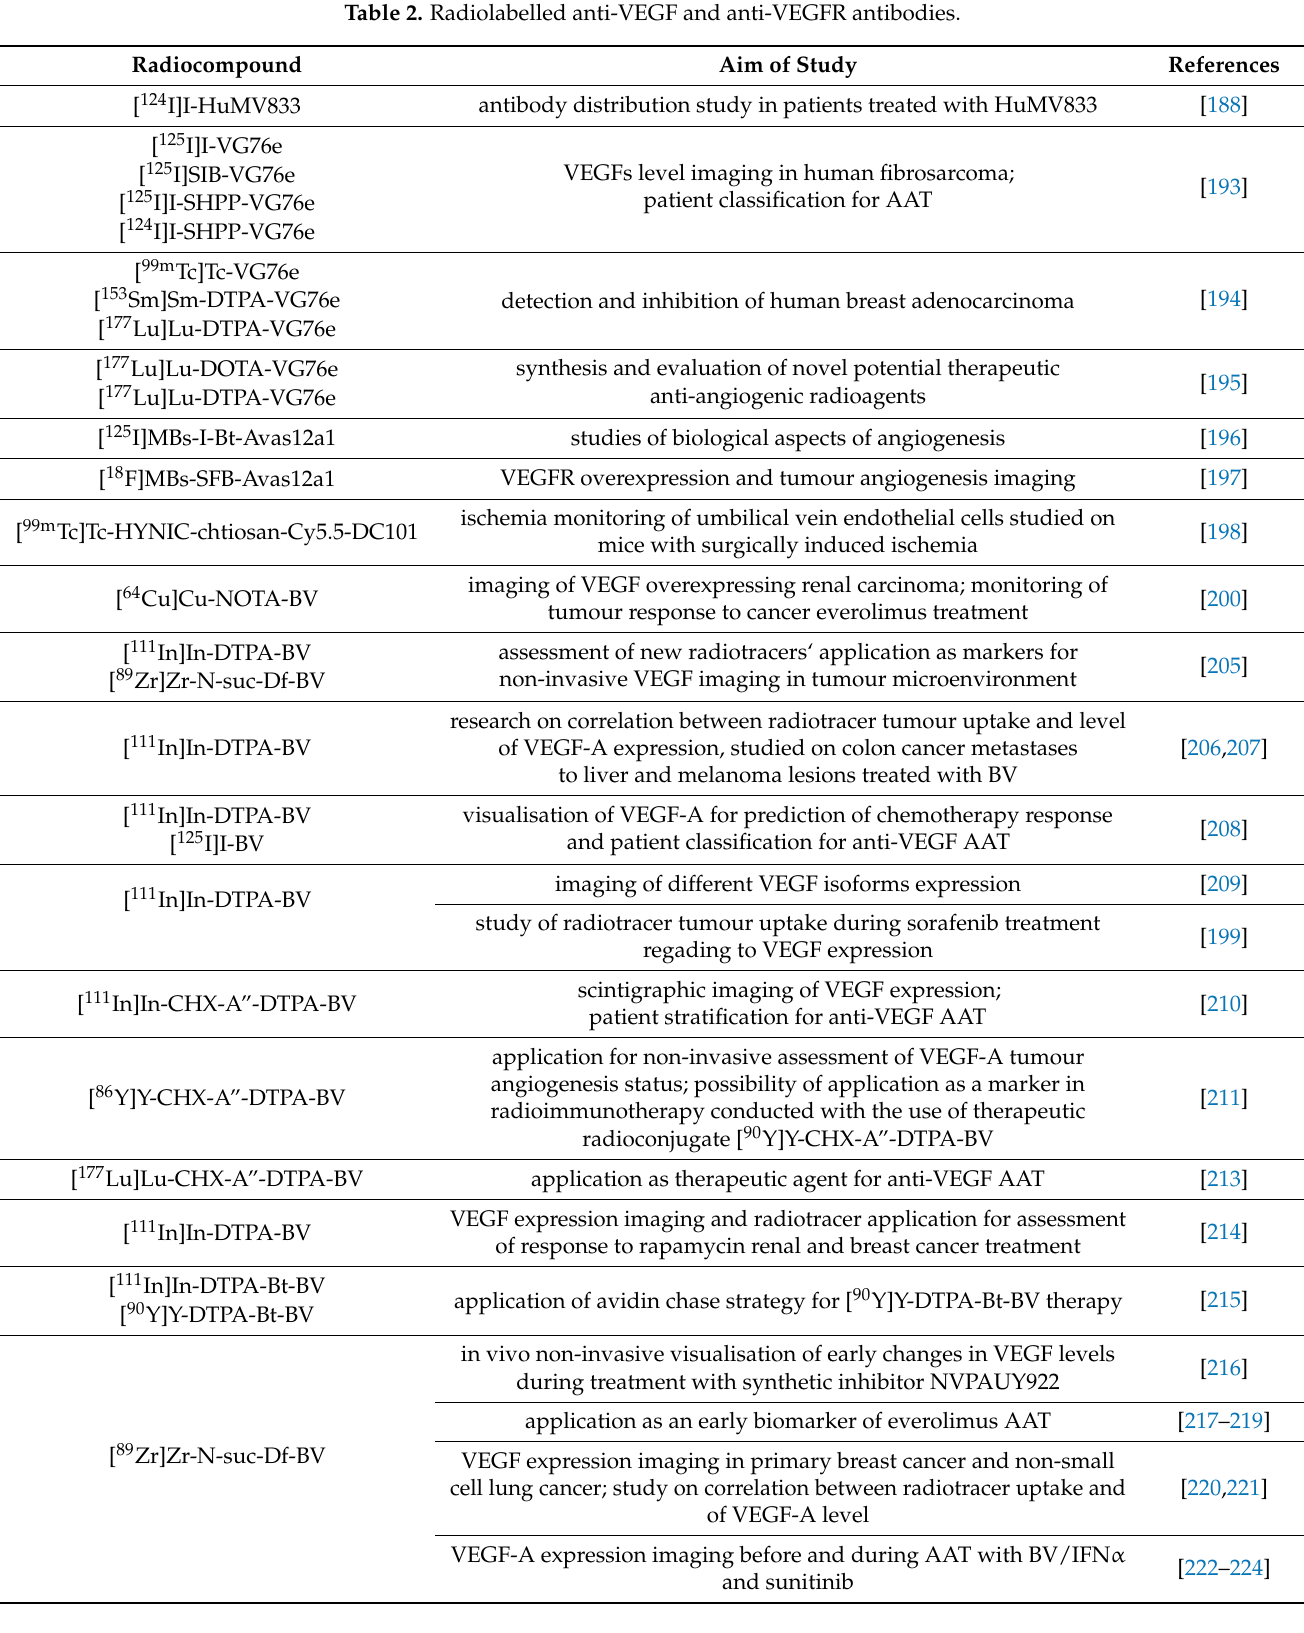
Table 2. Radiolabelled anti-VEGF and anti-VEGFR